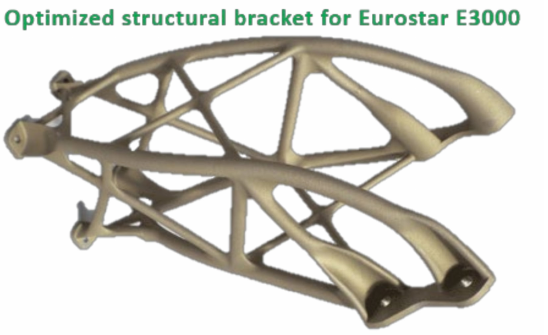
Figure 3. AM-made optimized bracket used for mounting the TMTC antennas onto the E3000 satellite